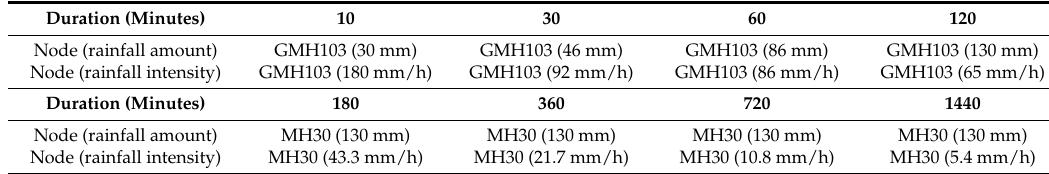
Table 1. Results of the first flooding nodes.